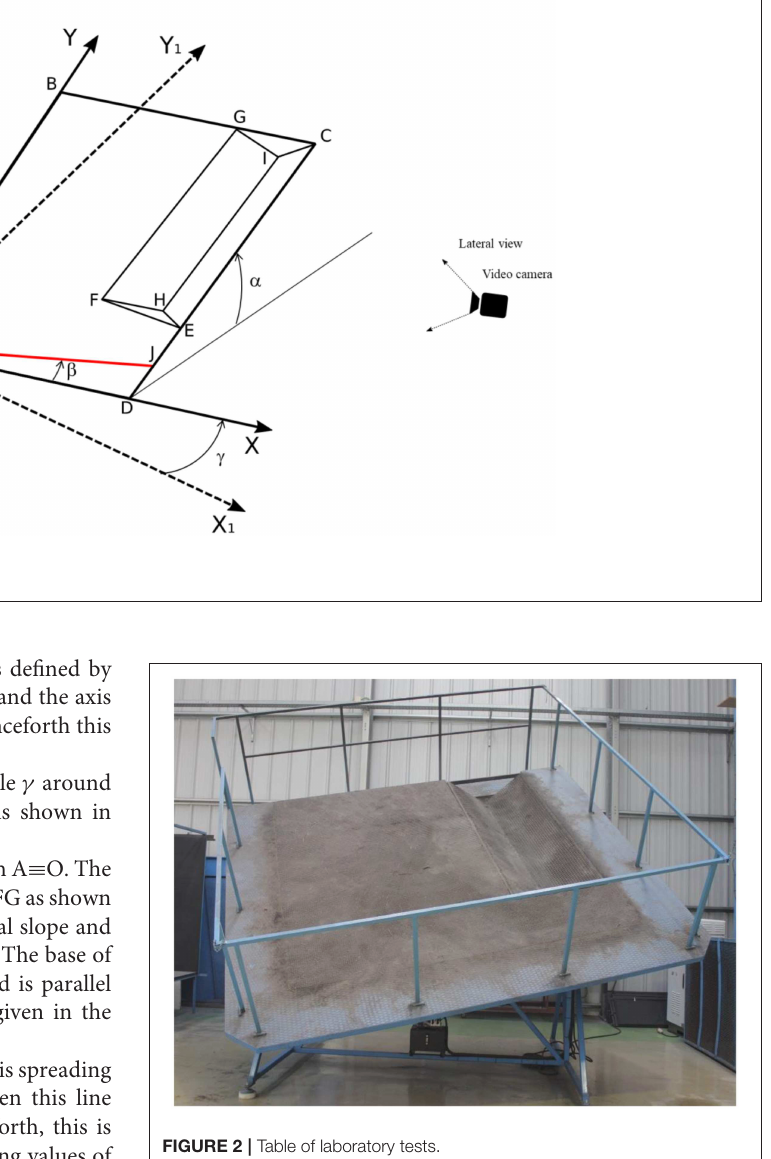
FIGURE 2 | Table of laboratory